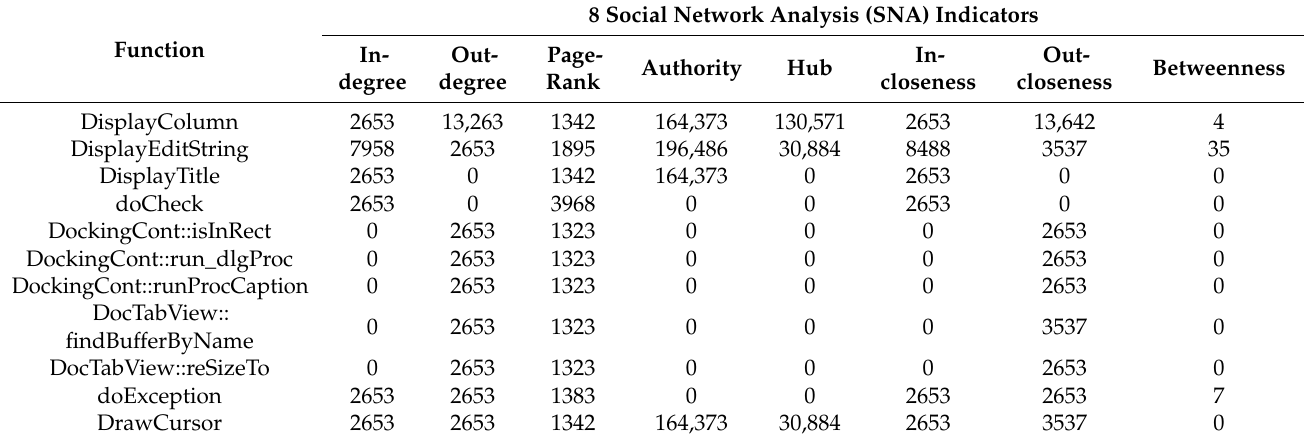
Table 3. Part of the network weight of 378 functions analyzed by 8 SNA indicators.